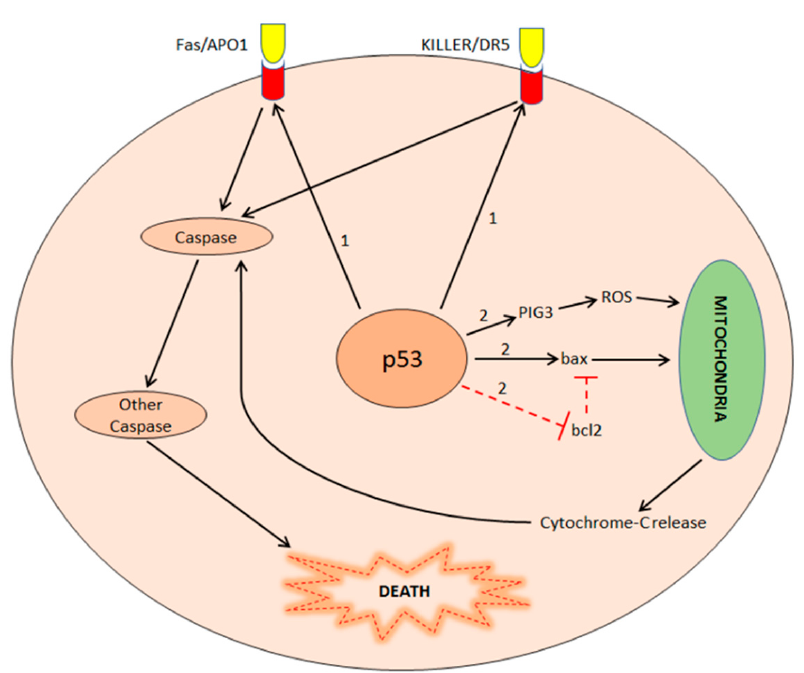
Figure 4. Apoptosis induction by p53 in extrinsic (1) and intrinsic (2) pathways. In the extrinsic pathway, p53 activates Fas/APO1 and KILLER/DR5 genes that result in the expression of two membrane receptors, activating the caspase cascade and cell death. In the intrinsic pathway, p53 induces pro-apoptotic proteins (PIG3, bax) and inhibits anti-apoptotic proteins (bcl2). Pro-apoptotic proteins induce cytochrome-C release by mitochondria and activation of the caspase cascade and cell death.